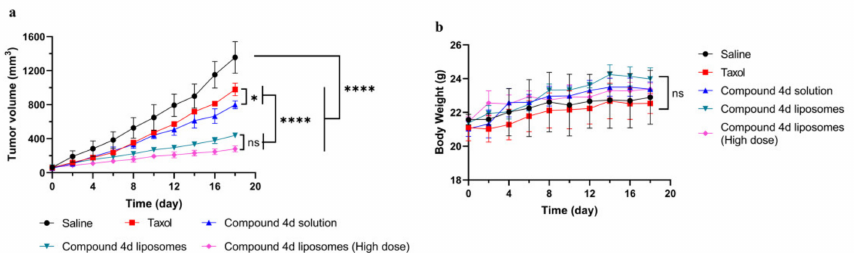
Figure 6. Compound 4d liposome against 4T1 xenograft tumor in vivo. ( a ) Tumor growth profiles. ( b ) Body weight. All data are presented as mean ± SD ( n = 5), * p < 0.05 and **** p < 0.0001 by two-tailed Student’s t test. “ns” mean “no